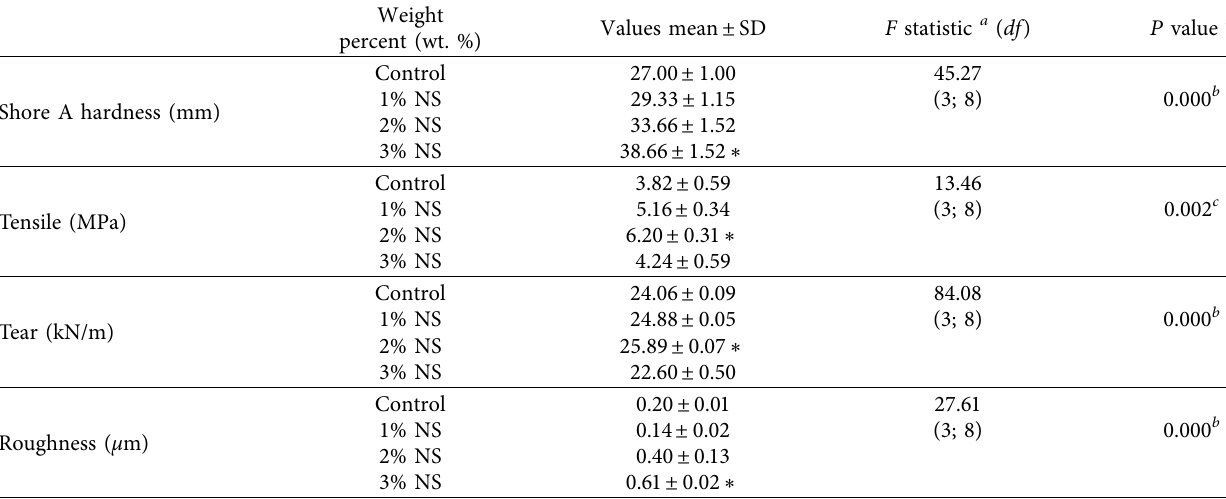
Table 3: Te comparison of 1%, 2%, and 3% wt. nanosilica (NS) addition on Tech-sil25 maxillofacial silicone mechanical